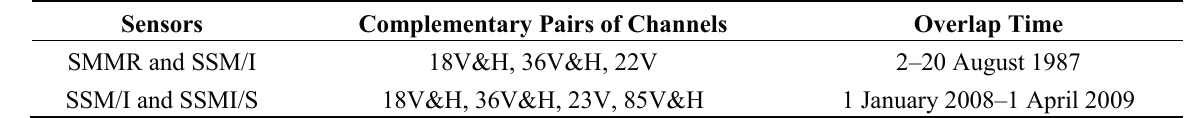
Table 2. Complementary pairs of channels and overlap times between SMMR